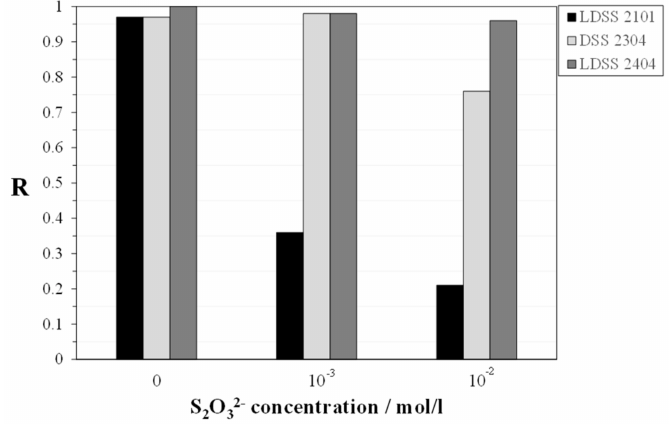
Figure 16. R index of the studied LDSS in NACE TM-0177 solution at 25 ◦ C and pH 2.7, in the absence and presence of 10 − 3 and 10 − 2 M S 2 O 32 −